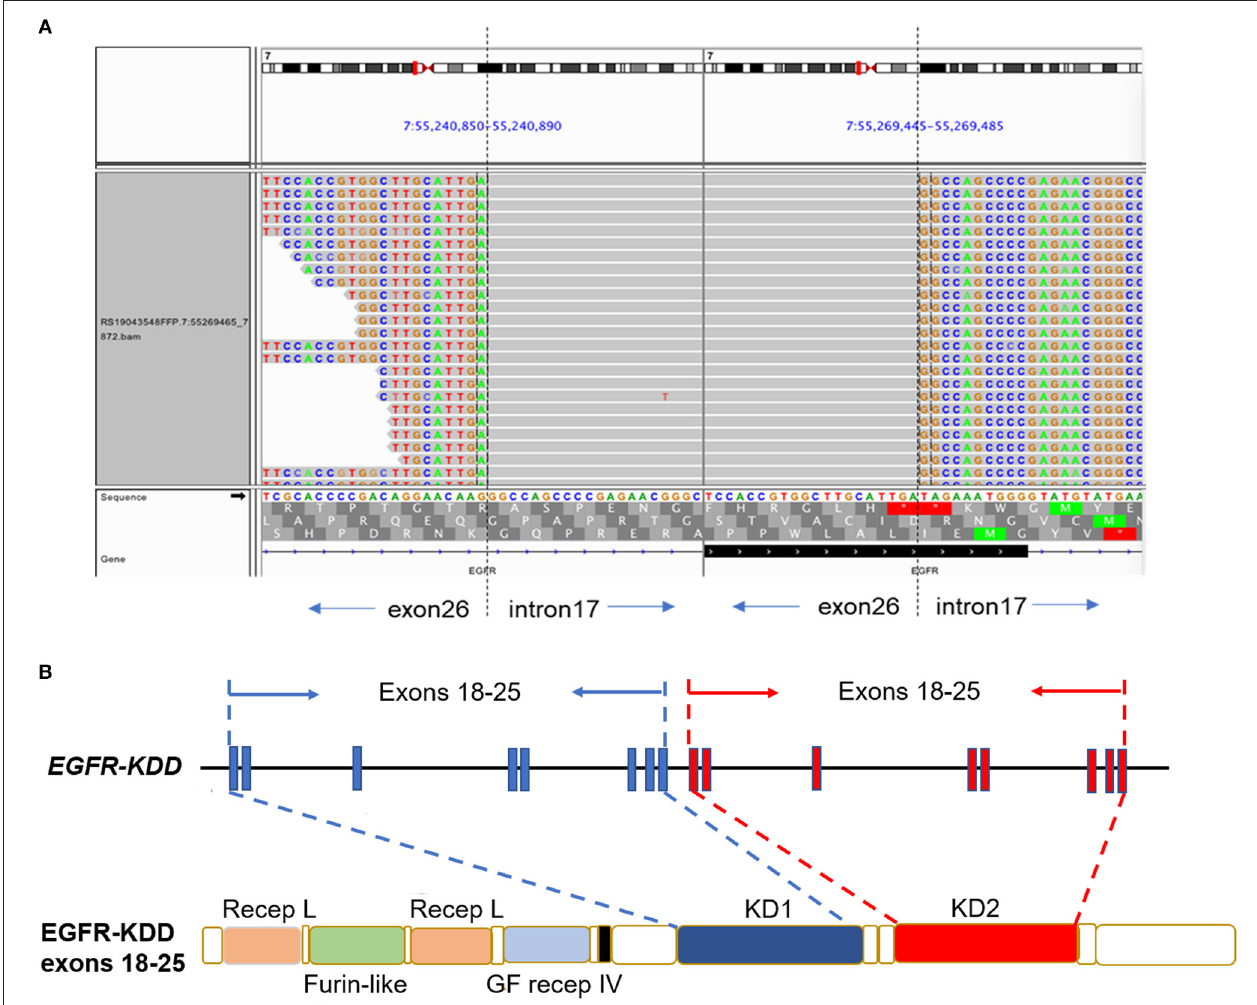
FIGURE 1 | The LUAD patient harboring canonical EGFR- KDD involving exons 18–25. (A) Visualization of canonical EGFR- KDD using the Integrative Genomics Viewer (IGV) browser. The dashed lines indicate the genomic breakpoints. (B) The genetic and protein domain structures of EGFR- KDD. EGFR /EGFR, epidermal growth factor receptor; KDD, kinase domain duplication; LUAD, lung adenocarcinoma; Recep L, Receptor L domain; Furin-like, Furin-like cysteine rich region; GF recep IV, Growth factor receptor domain IV; KD, tyrosine kinase